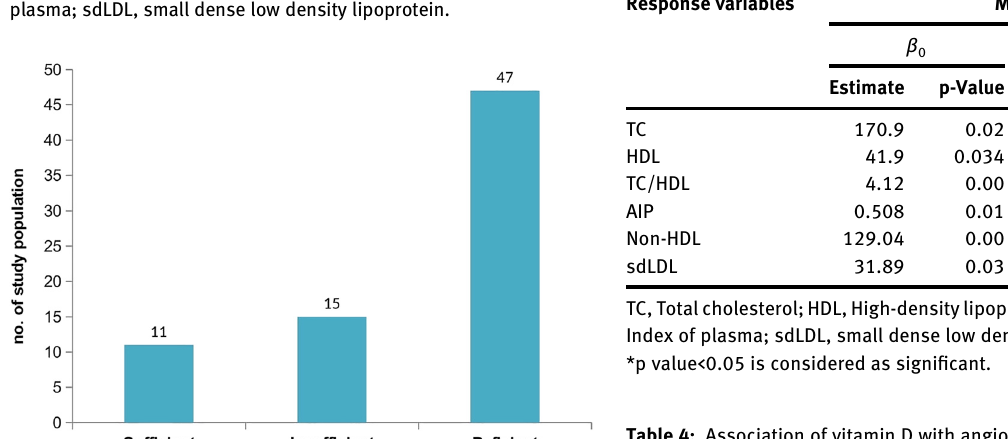
Table  : Association of vitamin D with angiographic severity.